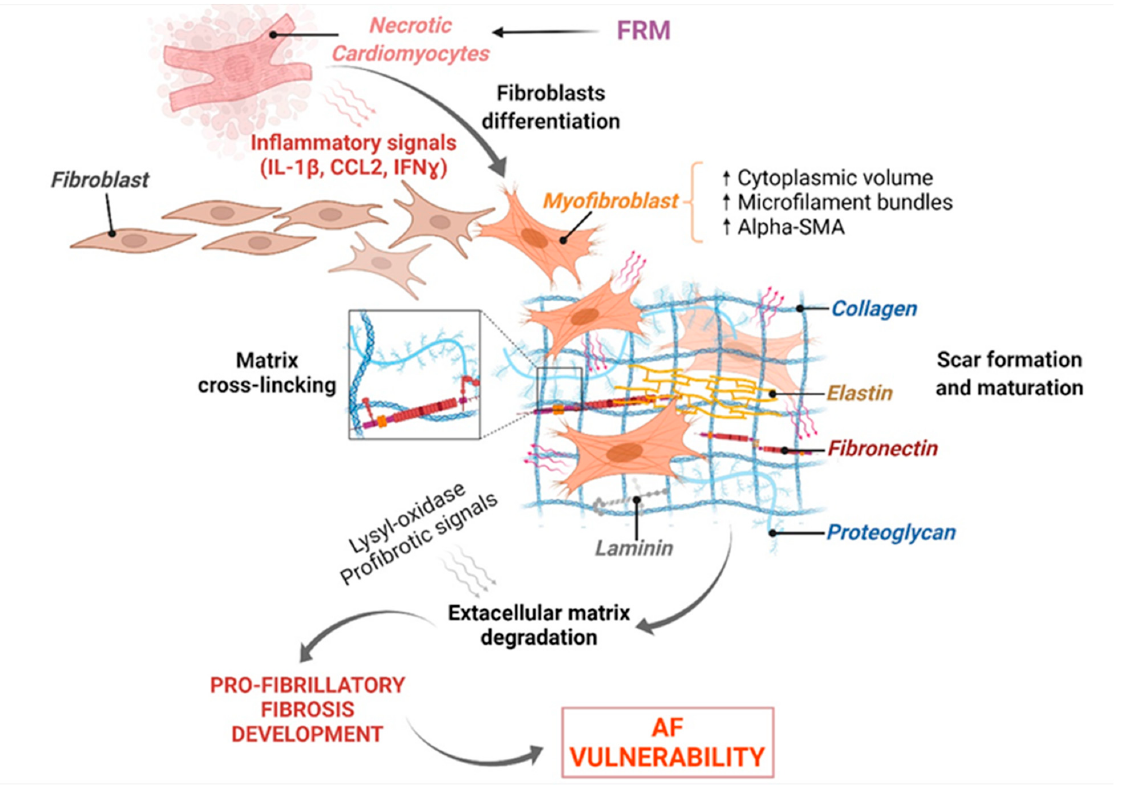
Figure 6. Cardiomyocytes and Fibroblasts’ orchestration of arrhythmogenic extracellular matrix degradation. During acute inflammation, failure in the occurrence of resolution mechanisms (FRM) promotes exacerbation of inflammatory signals generated from apoptotic cardiac cells and activated cardiac FB, leading to an aggravation of myocardial damages. The extracellular matrix (ECM) is intensively remodeled and degraded, promoting a persistence of fibrosis, scar formation, abnormal cardiac function, and increased risk of arrhythmias, including AF.